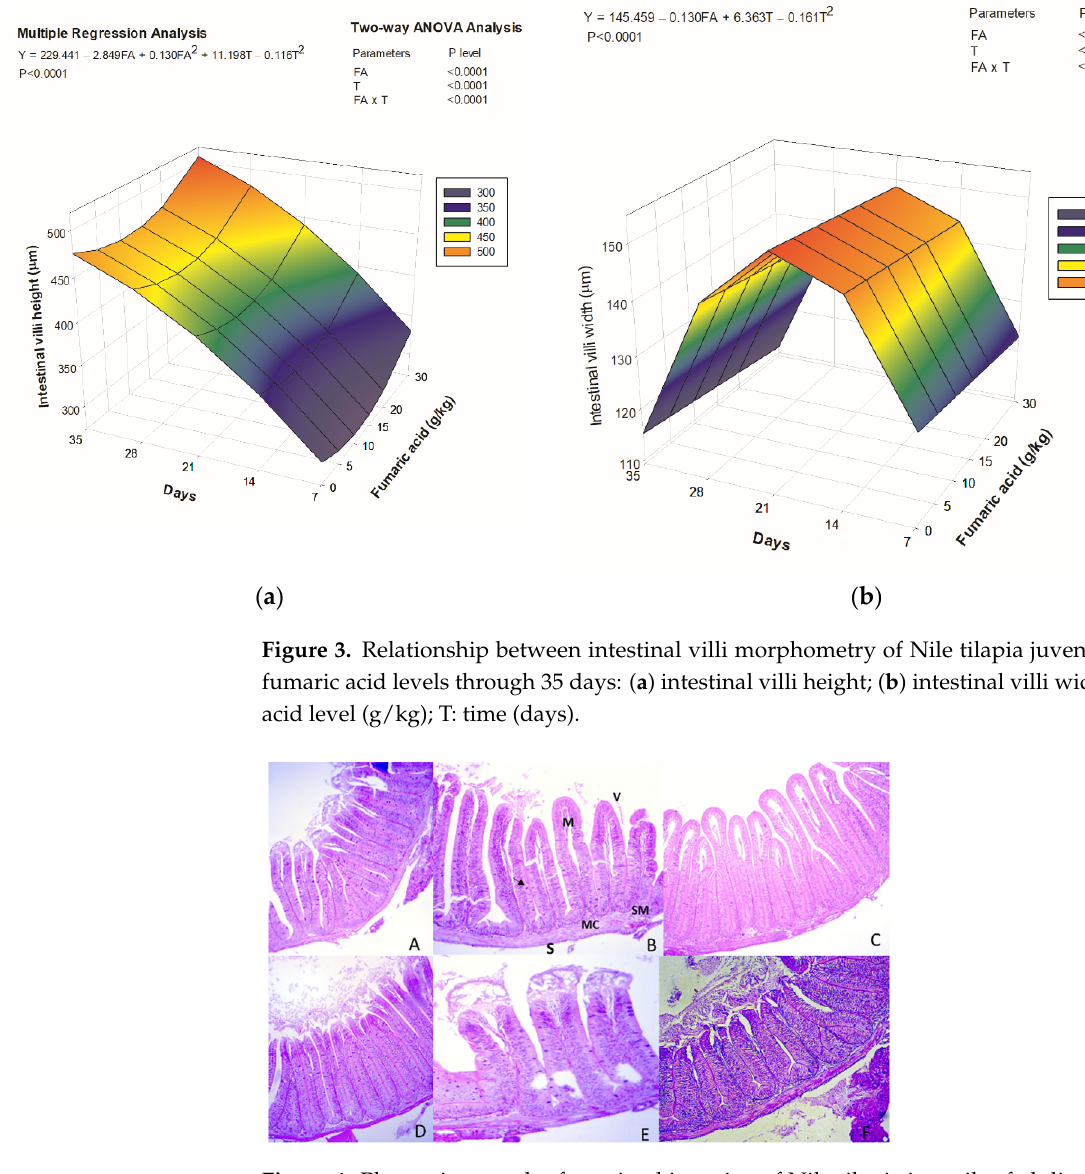
Figure 4. Photomicrograph of proximal intestine of Nile tilapia juveniles fed diets supplemented with fumaric acid levels of 0 g/kg ( A ), 5 g/kg ( B ), 10 g/kg ( C ), 15 g/kg ( D ), 20 g/kg ( E ) and 30 g/kg ( F ). In B, villi (V), mucosal epithelium (M), submucosa layer (SM), muscular layer (MC), serous layer (S) and goblet cell (arrow). HE staining. Bar = 200 μ m.